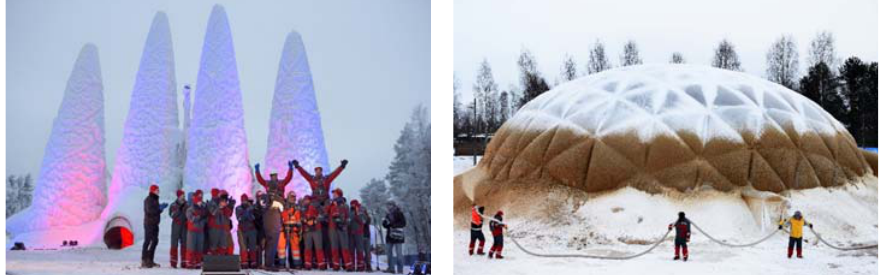
Figure 13: Ice structures built with pneumatic formwork by Pronk [17, 18].